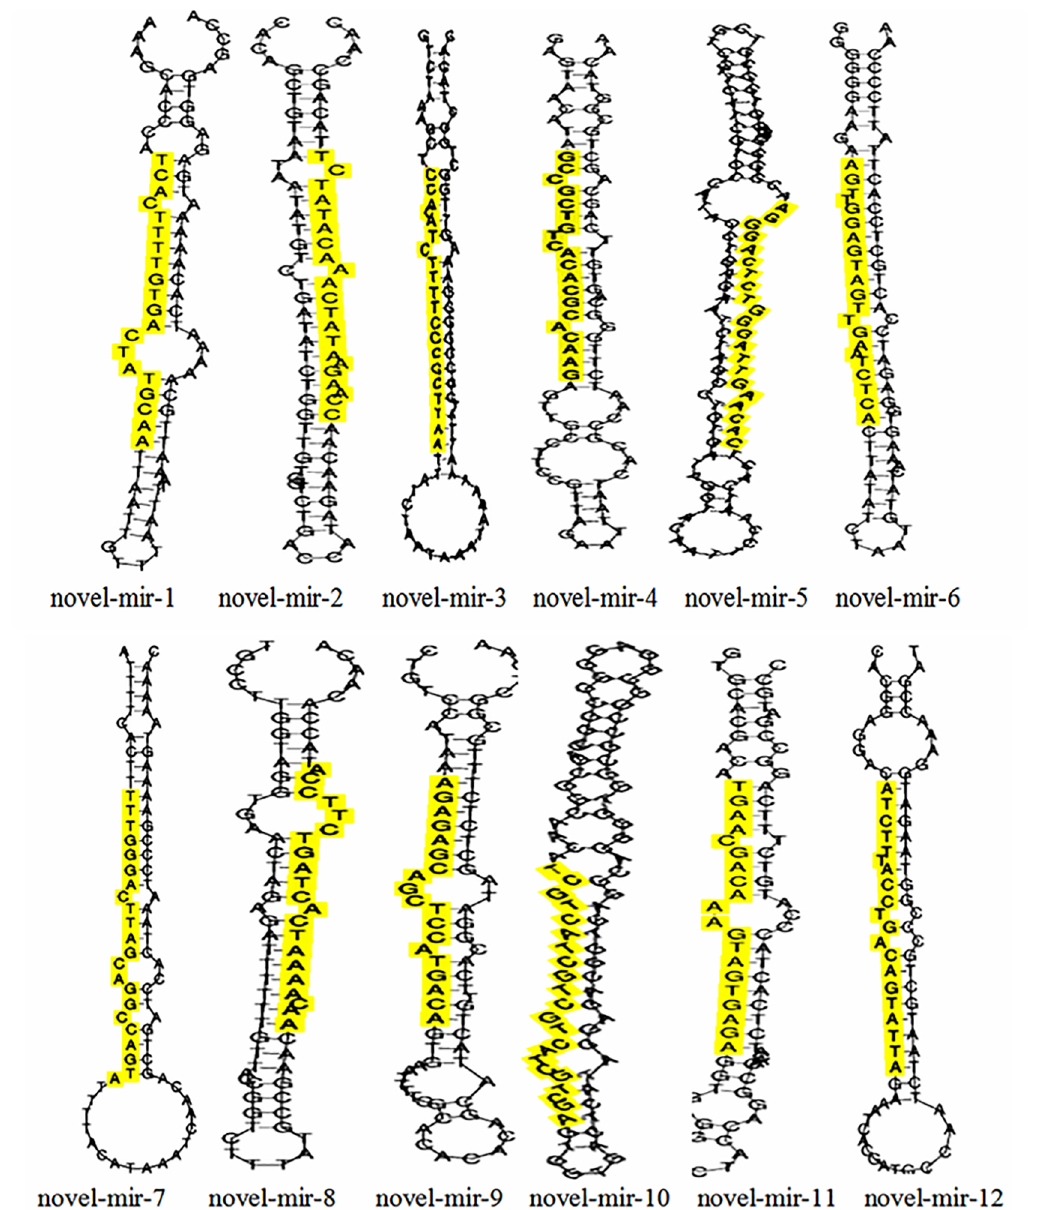
Fig 3. Putative folding structure of predicted novel miRNA precursors in NG and WG libraries. The yellow shadingregions in each structure delegatedthe mature predictednovel miRNA sequence.